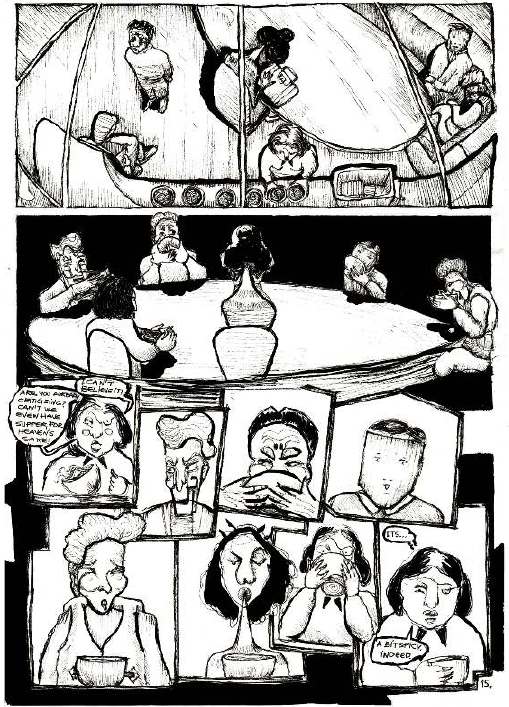
Credits: Amine Barbuda.